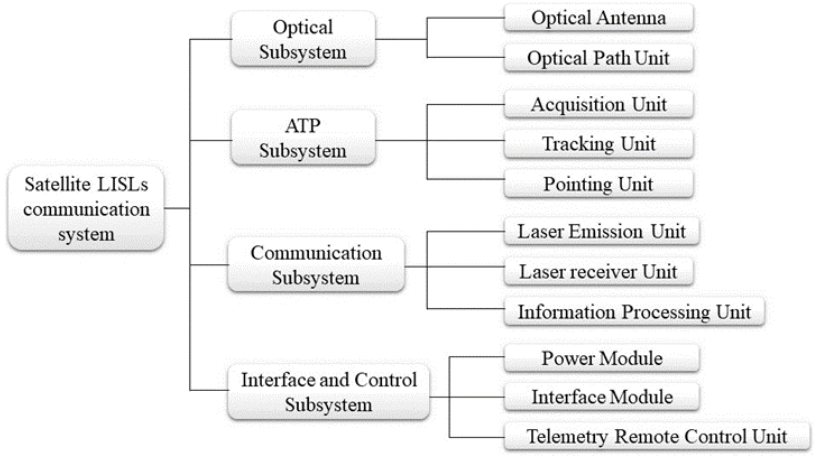
Figure 1. Satellite LISLs communication system.